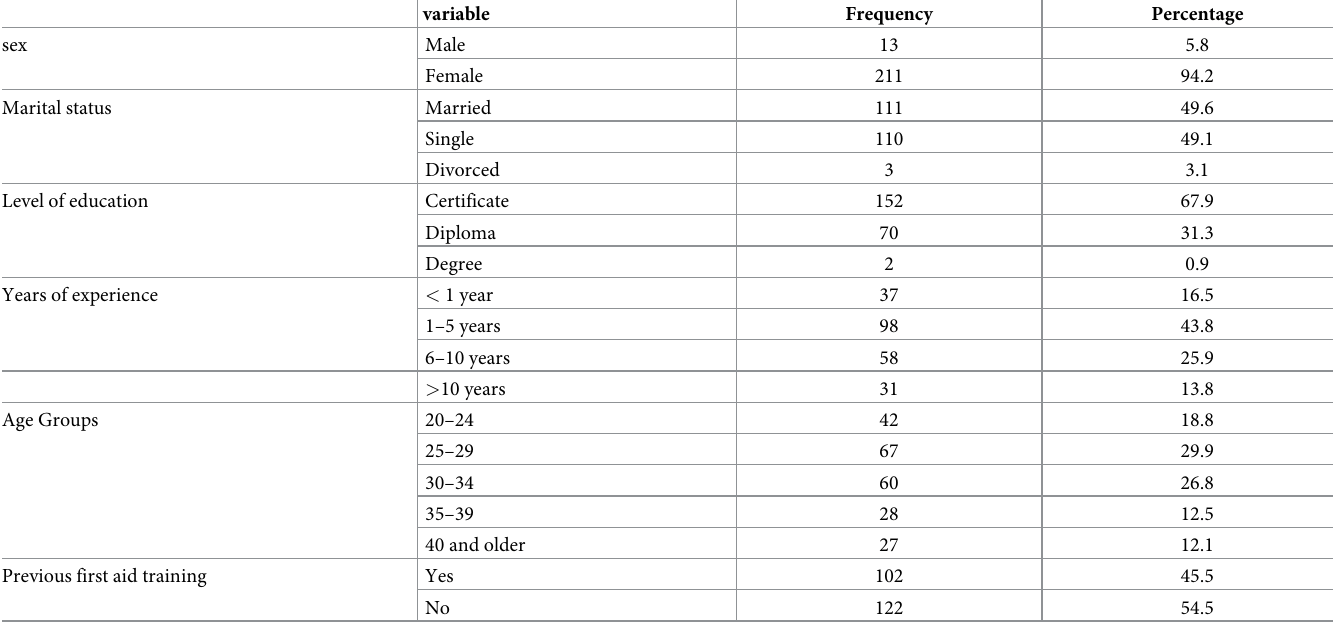
Table 1. Socio-demographic characteristics of kindergarten teachers among government schools in Addis Ababa Ethiopia,